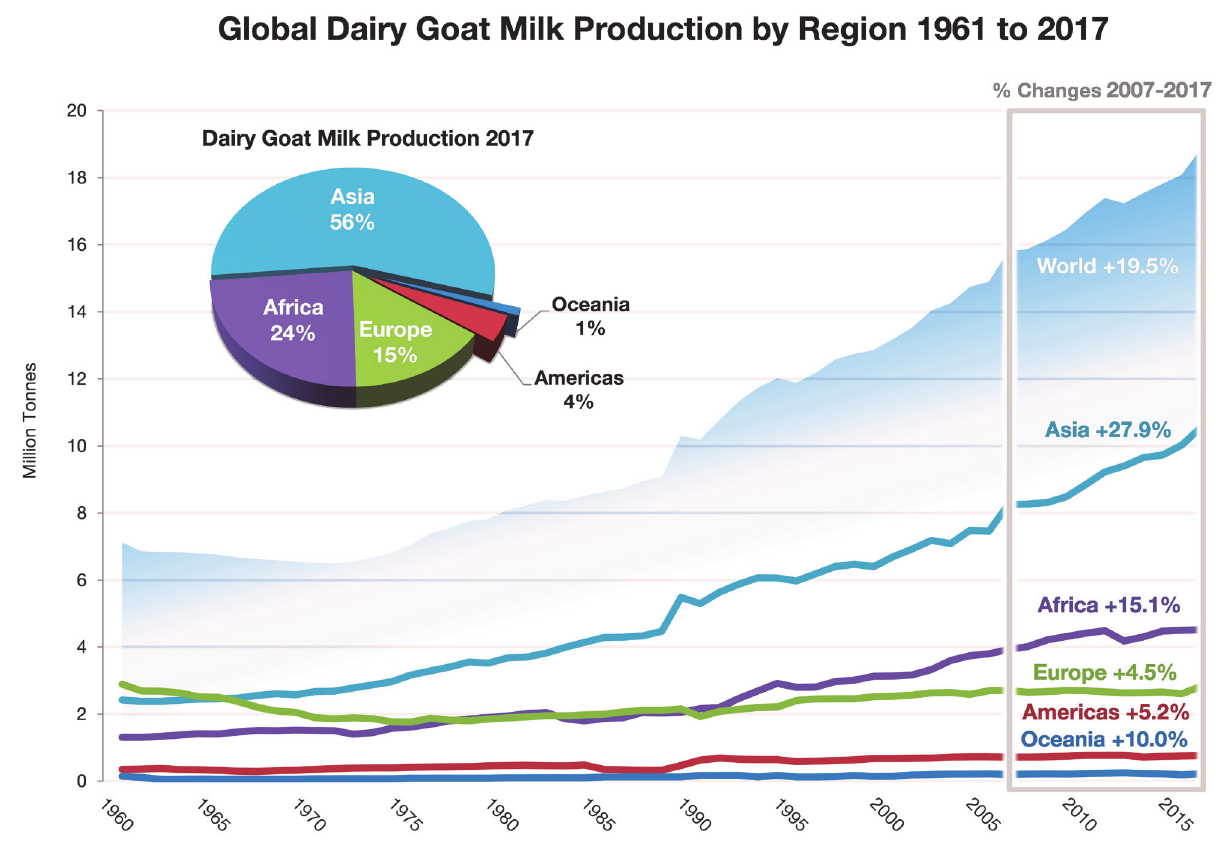
Figure 2. Global trends of goat milk production (Tonnes) from 1961 to 2017 (Compiled from [4], aggregate, may include official, semi-official, estimated or calculated